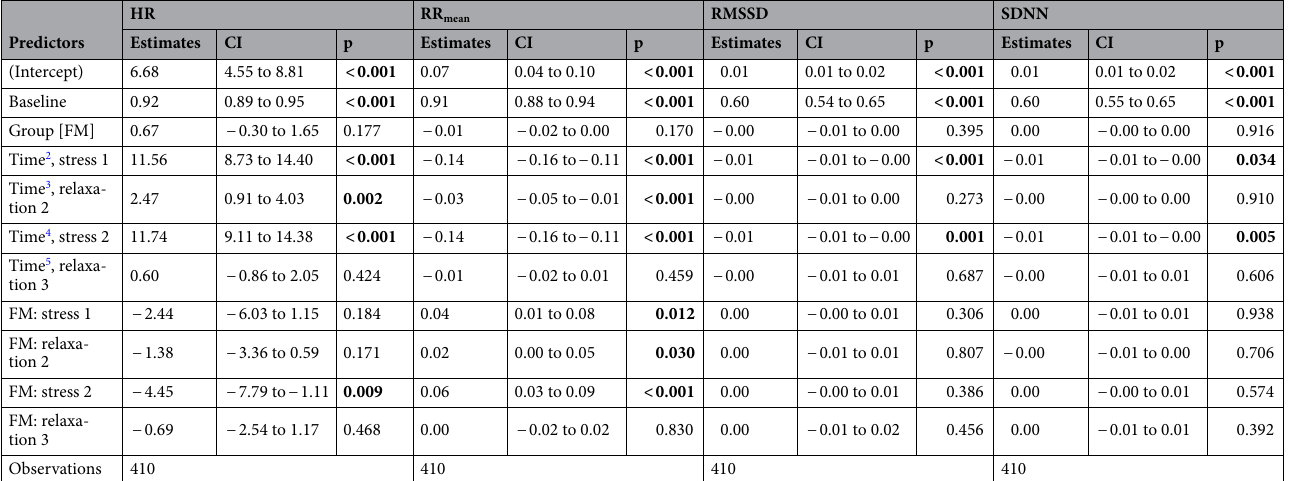
Table 2. Generalized linear models for heart rate (HR), mean interval between heart beats (RR mean ), root mean squared interval differences of successive beats (RMSSD), and the standard deviation of intervals between normal heart beats (SDNN), comparing fibromyalgia patients (FM) and healthy controls, unadjusted for lifestyle factors. Significant values are in bold.